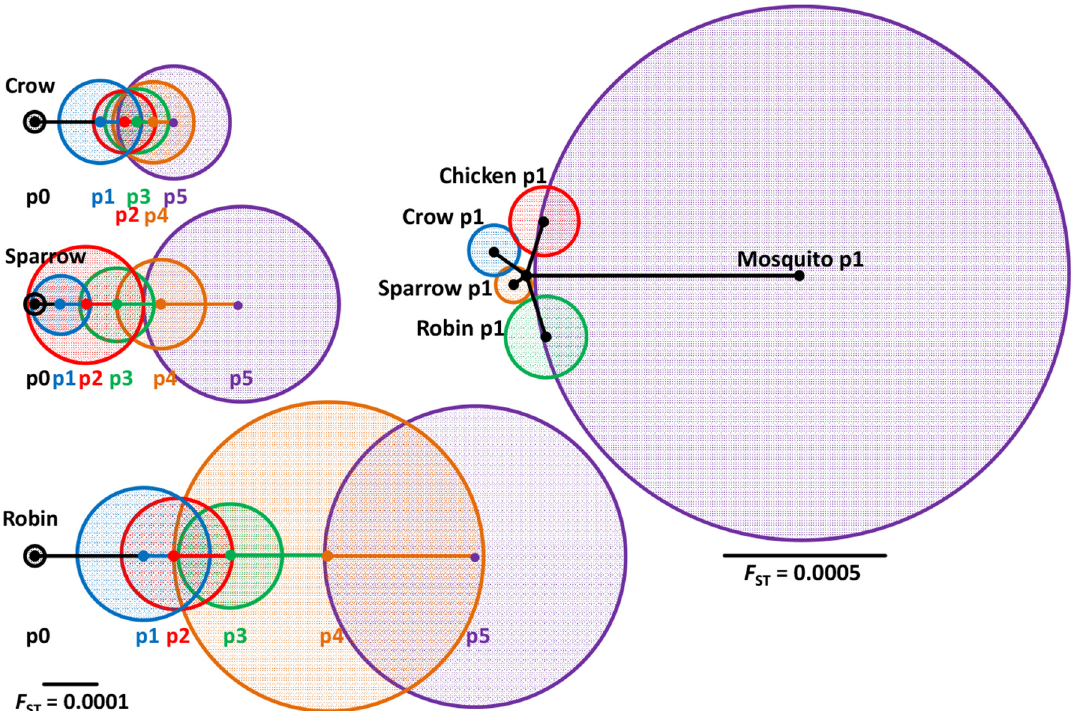
Fig 5. Differential interhost divergence of viral populations between individuals, sequential passage and host species. Circle diameters represent divergence ( F ST ) between individuals within a passage. Lines connecting circle centers represent between-passage divergence and were measured using combined replicates. F ST from replicate means at p5 among crows (2 × 10 – 4 ), sparrows (4 × 10 – 4 ) and robins (6 × 10 – 4 ) were significantly different ( P = 0.0500). F ST was similar after a single passage in wild birds and chickens (~2 × 10 – 4 ) and significantly different from F ST after a single mosquito passage (2 × 10 – 3 , P = 0.0174, Kruskal-Wallis test).